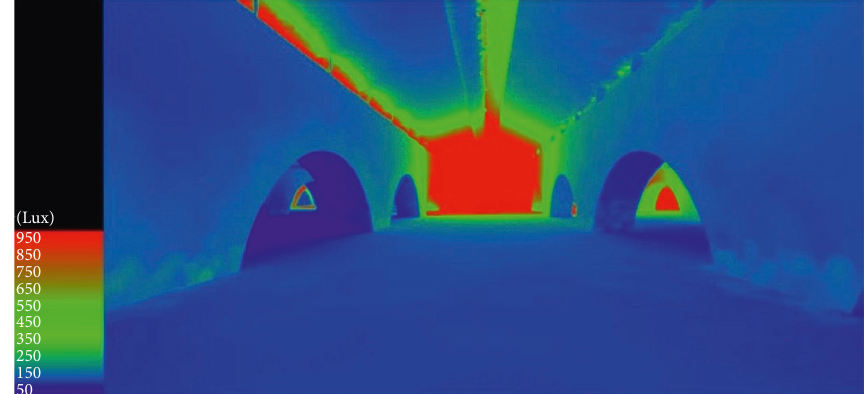
Figure 10: Natural daylight simulation, winter solstice. 3D illuminance representation (lx). Nave 3, Atarazanas , Seville, Spain.